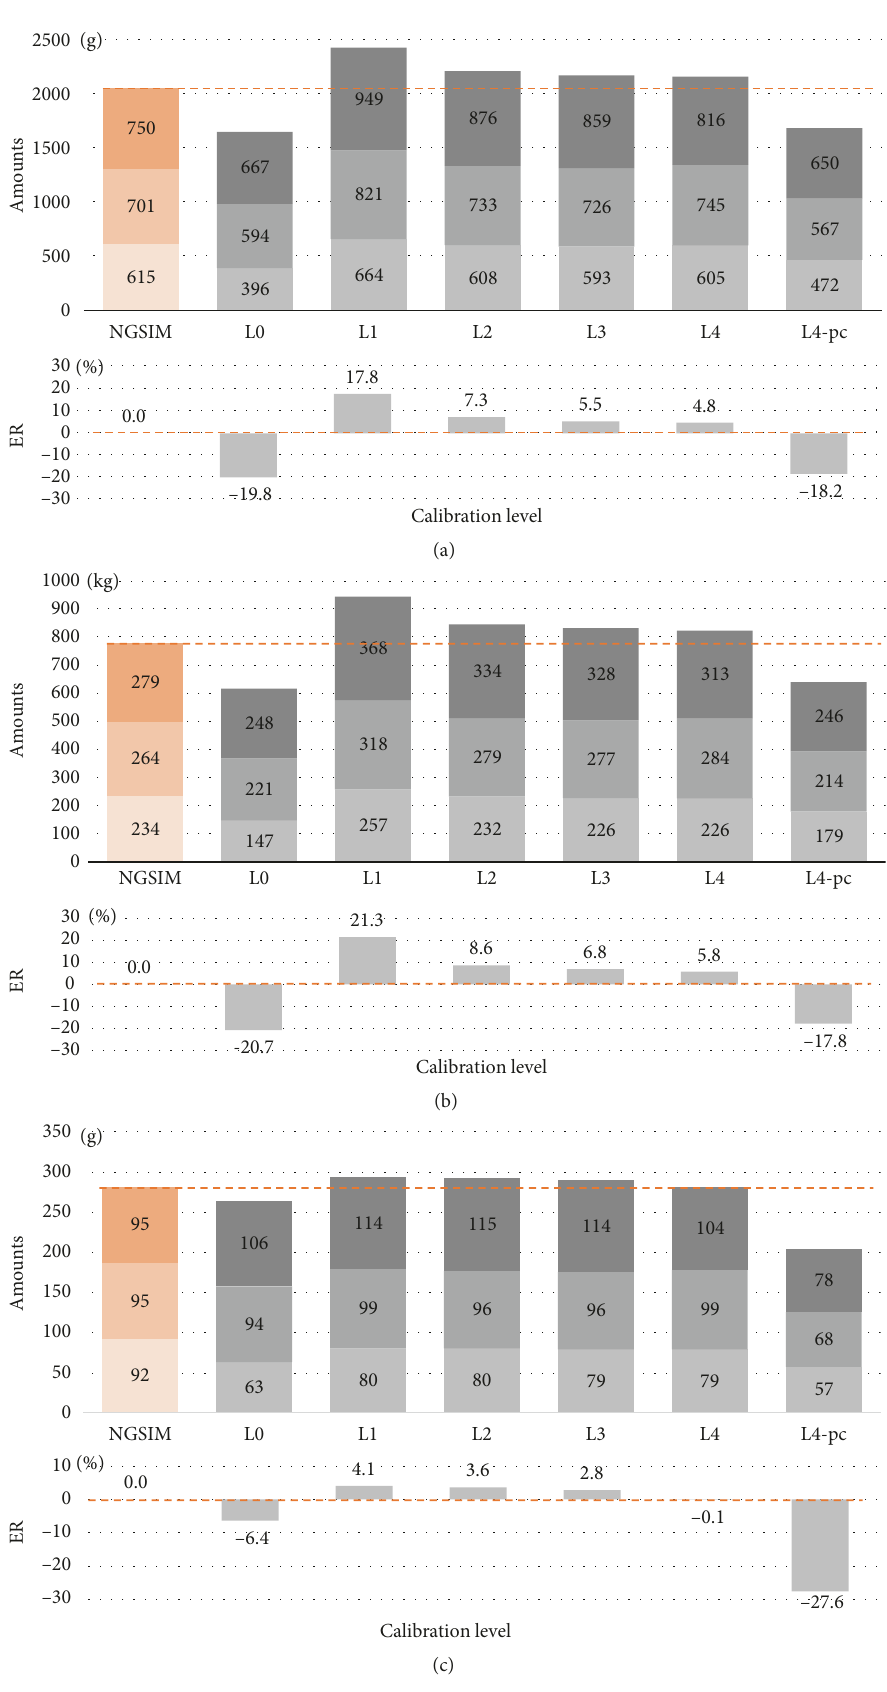
Figure 6: Comparisons of emissions from each calibration level and ground truth emissions in the three 15-min periods considered and , and (c) NO totals for: (a) CO, (b) CO 2 x